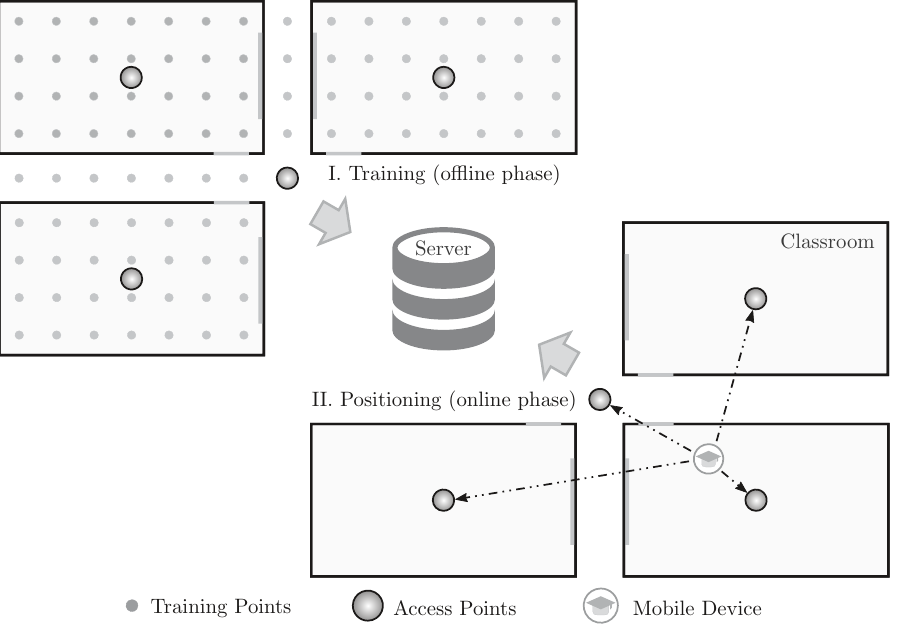
Figure 1. The two phases of a centralized fingerprint-based indoor positioning system implemented in a campus scenario: training and positioning.